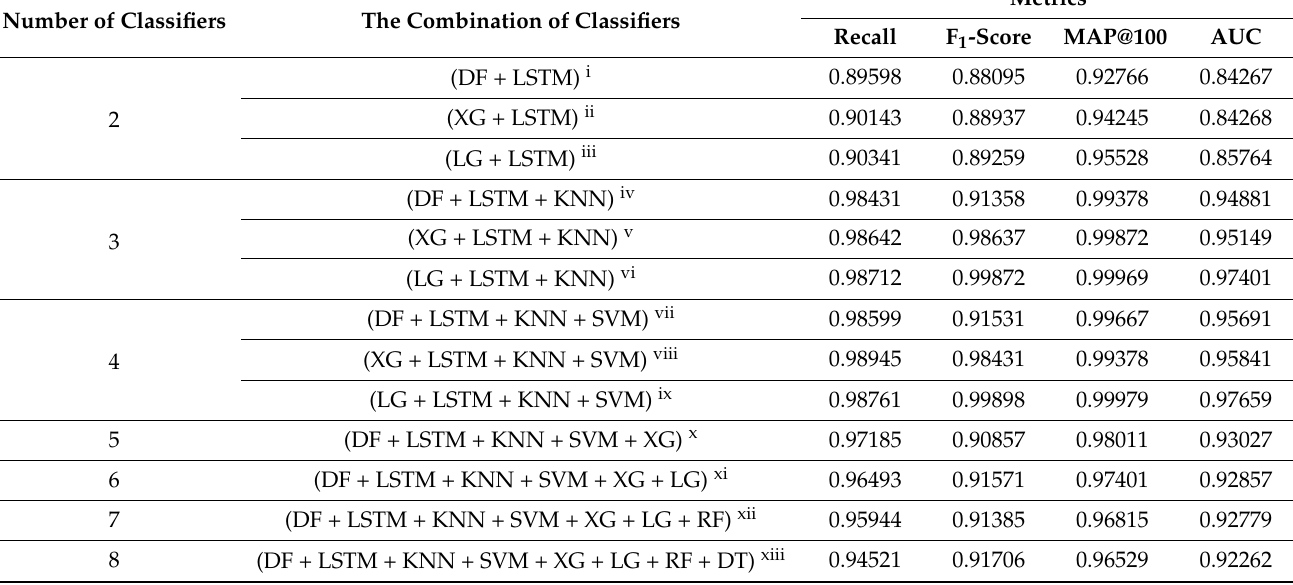
Table 6. The experimental results of each classifier combination under feature set Y